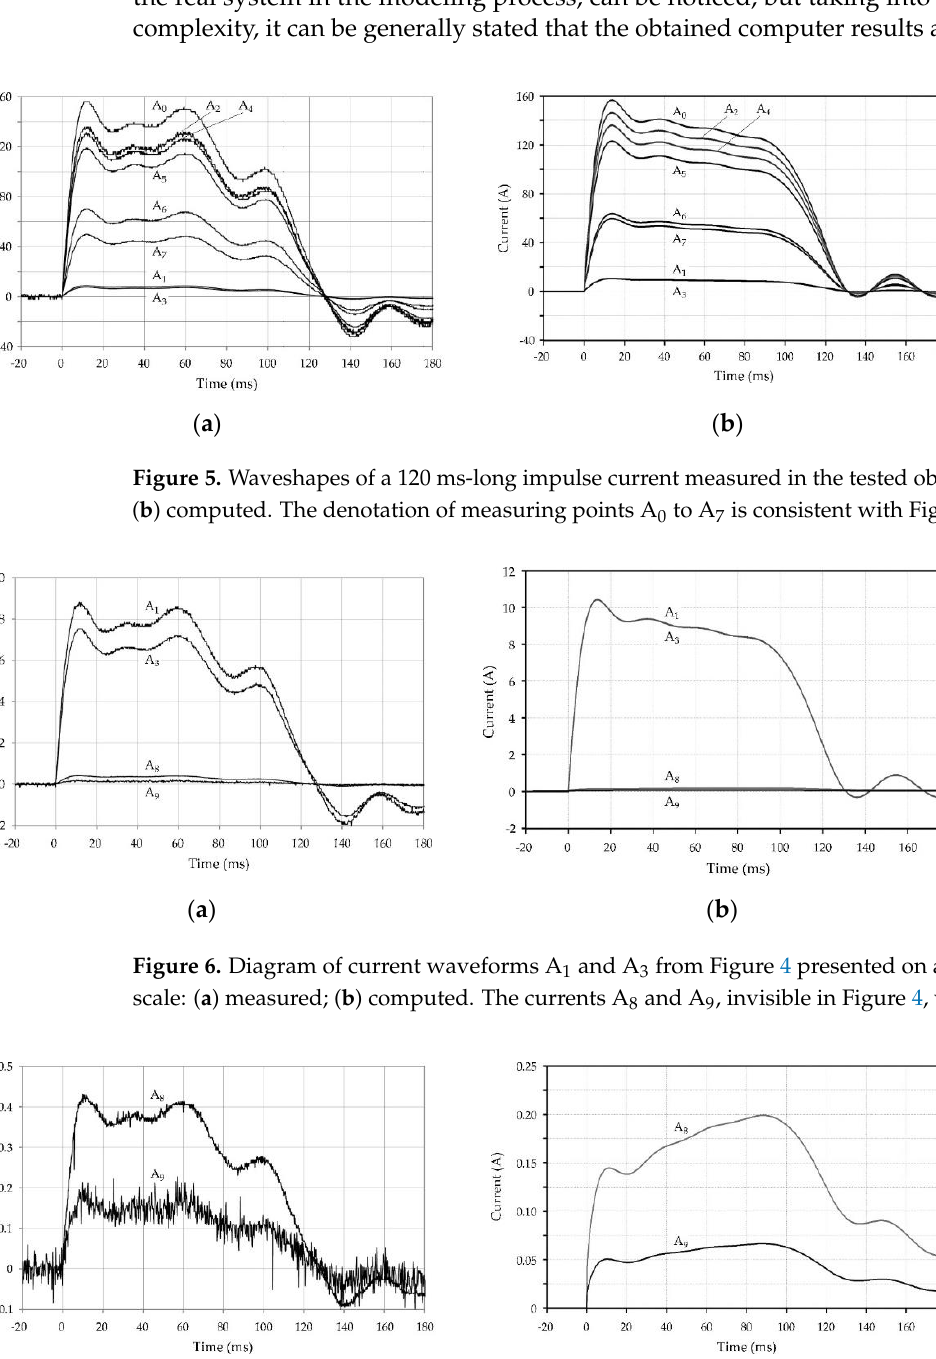
Figure 7. Diagram of current waveforms A 8 and A 9 from Figure 5, presented on a matched current scale: ( a ) measured; ( b ) computed.